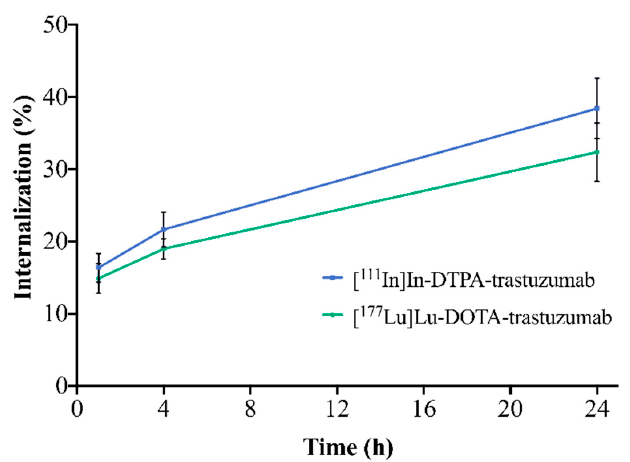
Figure 4. Internalization of [ 111 In]In-DTPA-trastuzumab and [ 177 Lu]Lu-DOTA-trastuzumab into SK-BR-3 cells after 1, 4 and 24 h of incubation. Values are expressed as mean ± SD ( n = 4).